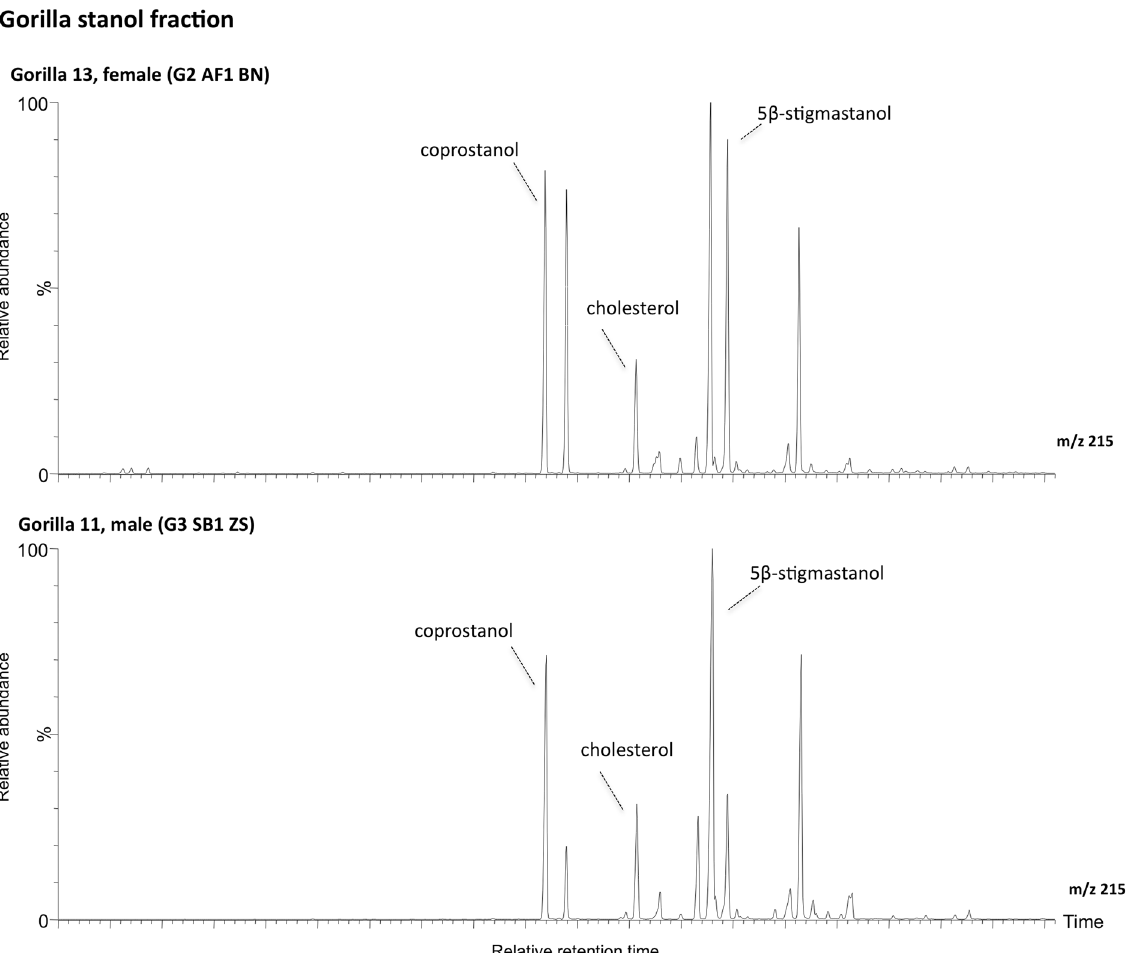
Fig 7. Gorilla stanol partial chromatogram. Comparison of the m/z 215 ion chromatograms for the neutral lipid fraction from sample 13 (Gorilla female) and 11 (Gorilla